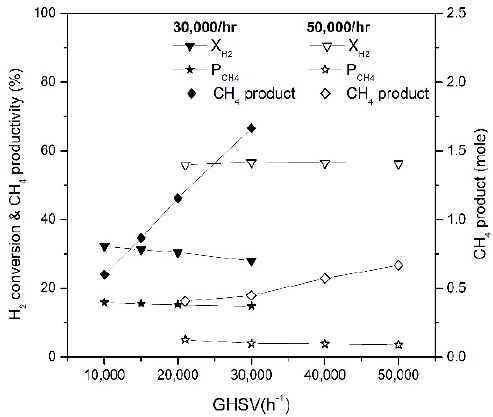
Figure 9. Effect of GHSV on the CH 4 productivity and CH 4 products (H 2 /CO 2 = 4).